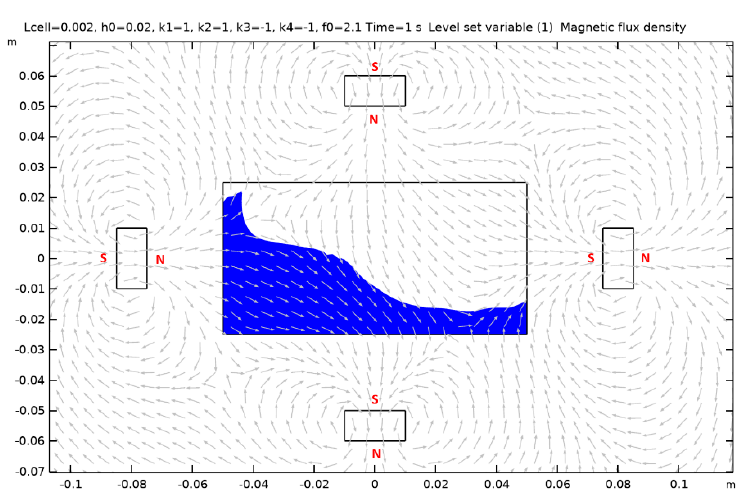
Figure A13. Case 14.